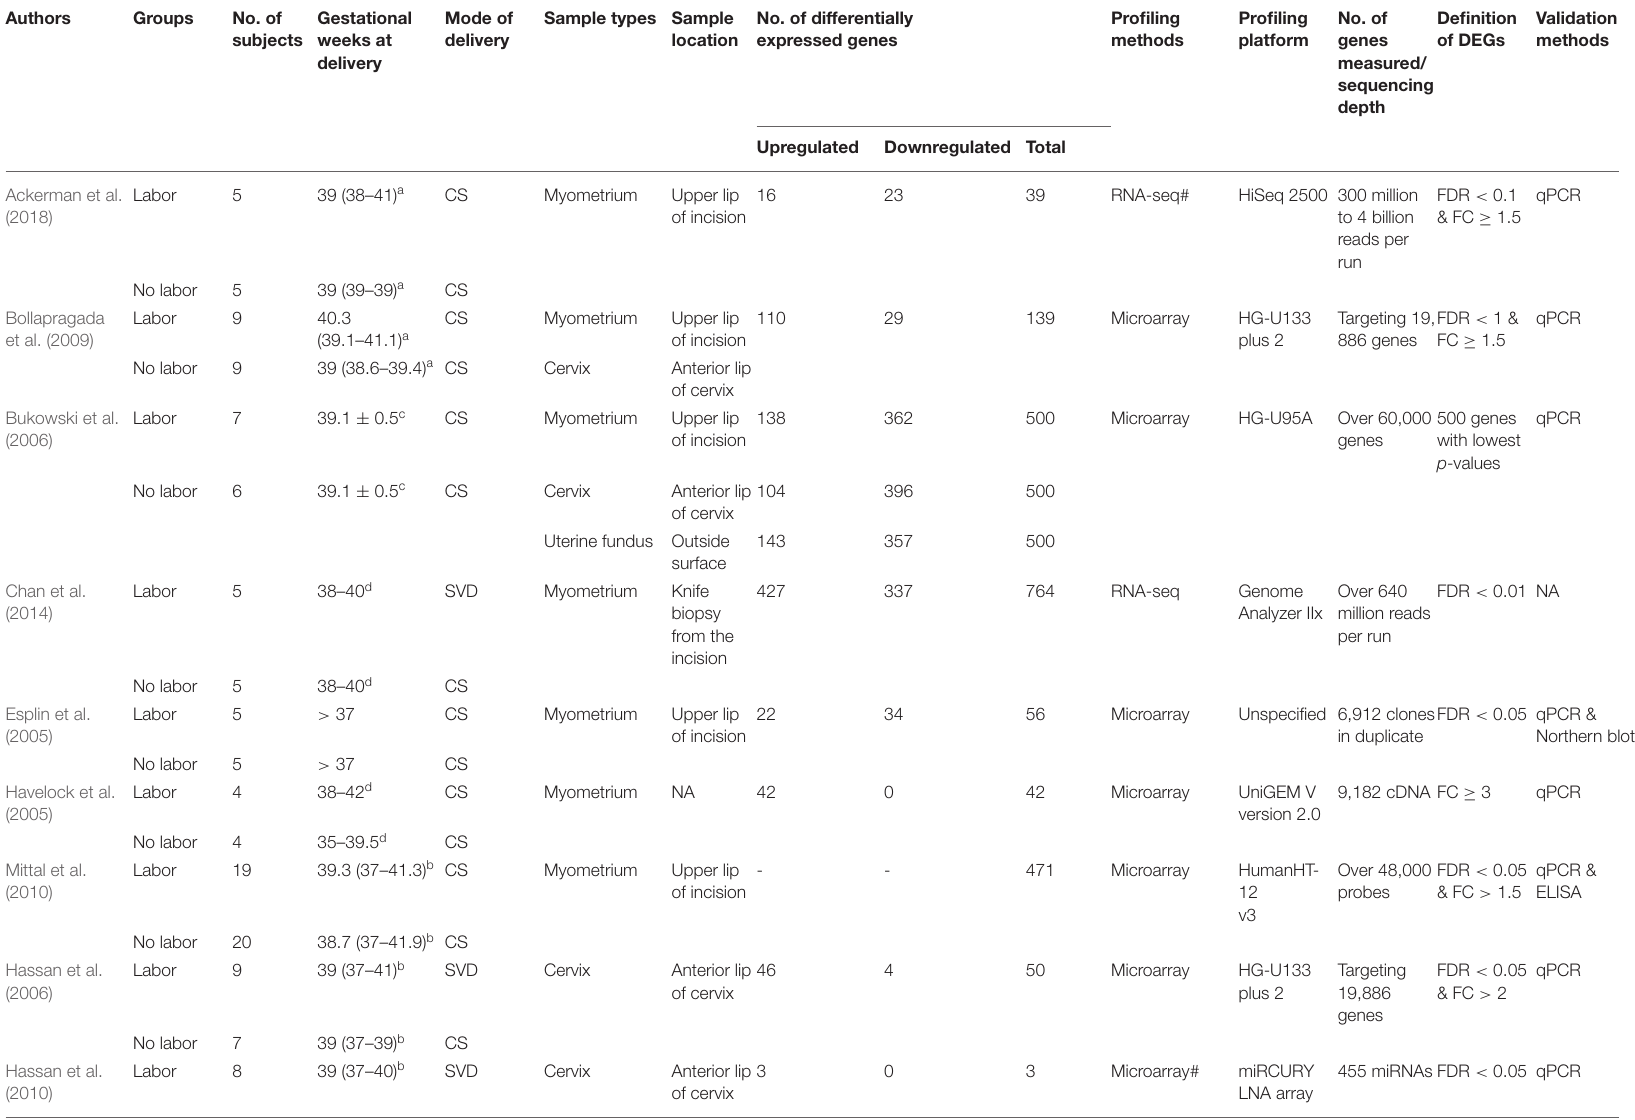
TABLE 1 | Basic characteristics of included